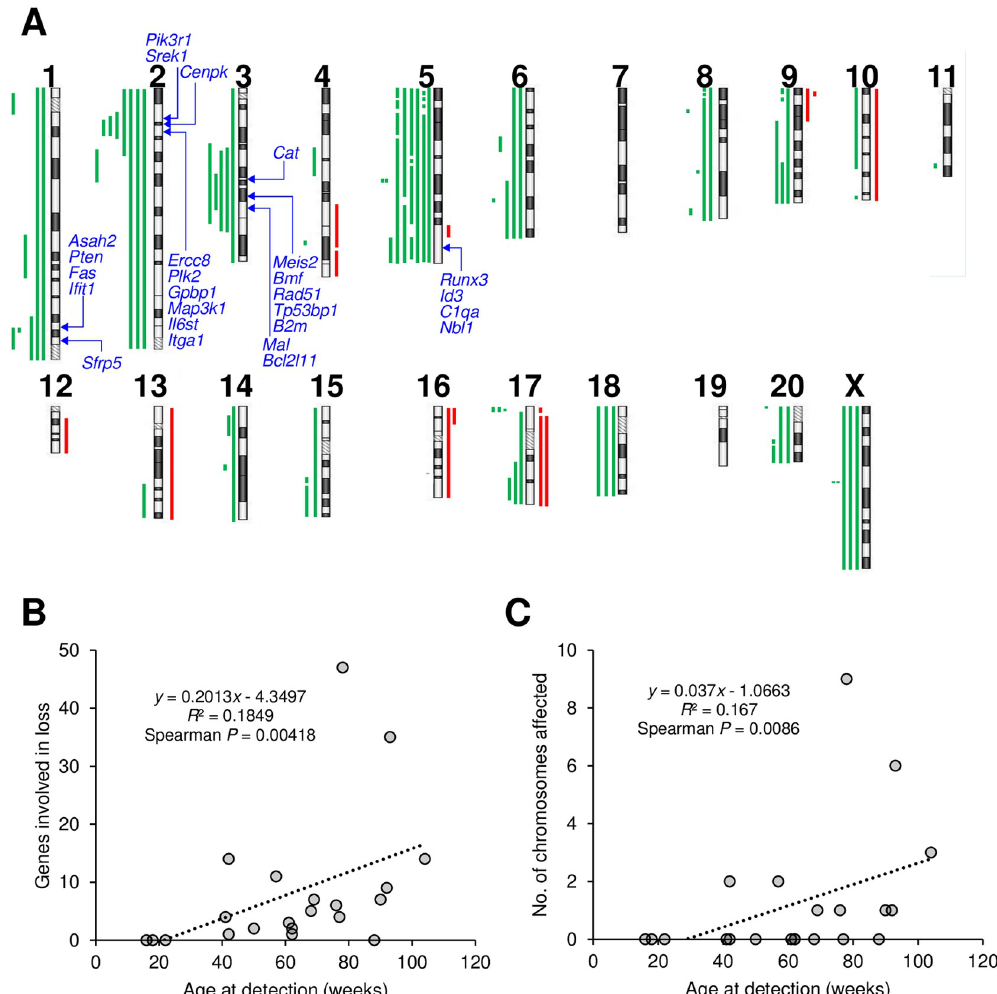
Fig 2. Copy-number aberrations in mammary carcinomas from (SD × COP)F 1 rats. A, Chromosomal losses (green) and gains (red) in 21 tumors. Aberrations observed in the same carcinoma are arranged vertically, whereas those in different carcinomas are side by side. Locations of genes examined in the expression analysis are shown in blue (see Fig 4 and text). B and C. Correlation between age at tumor detection and genomic changes in tumors. B, Number of breast cancer–related genes affected by copy number loss. C, Number of chromosomes with > 80% copy number